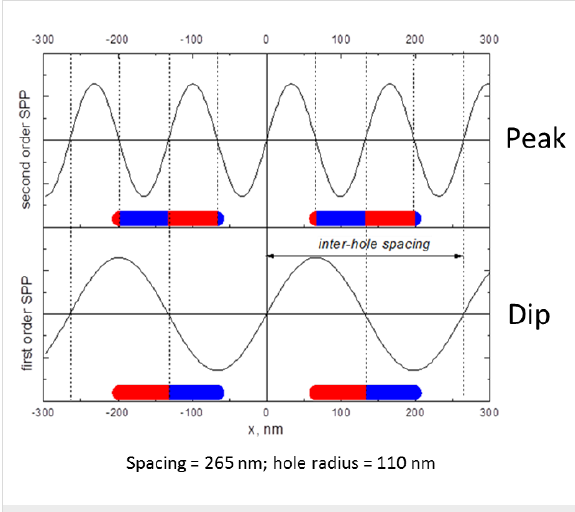
Figure 4: Schematic view of the first order and second order BW-SPP’s charge oscillations for the hole